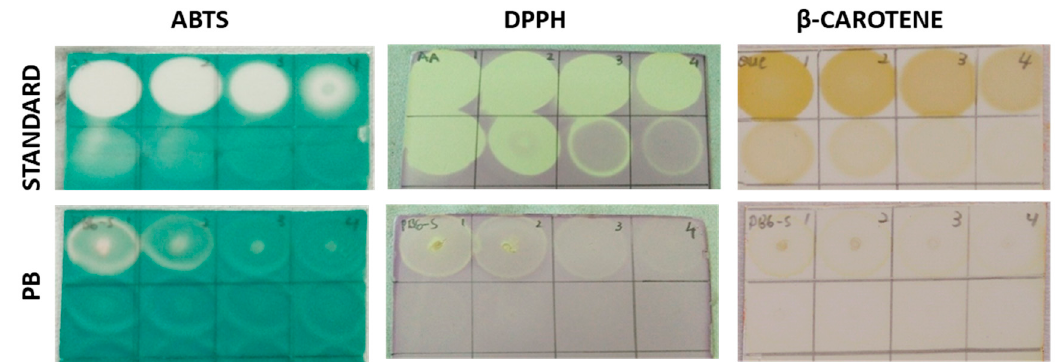
Figure 3. Dot-blot antioxidant of PB aqueous extract. Representative of dot-blot image of PB aqueous extract dilution series for ABTS, DPPH, and β -carotene bleaching antioxidants assay with ascorbic acid and quercetin as standard, respectively. For each assay, the initial concentration tested was 5.0 mg and further diluted in a 1:2 fold ration. ( n = 3).